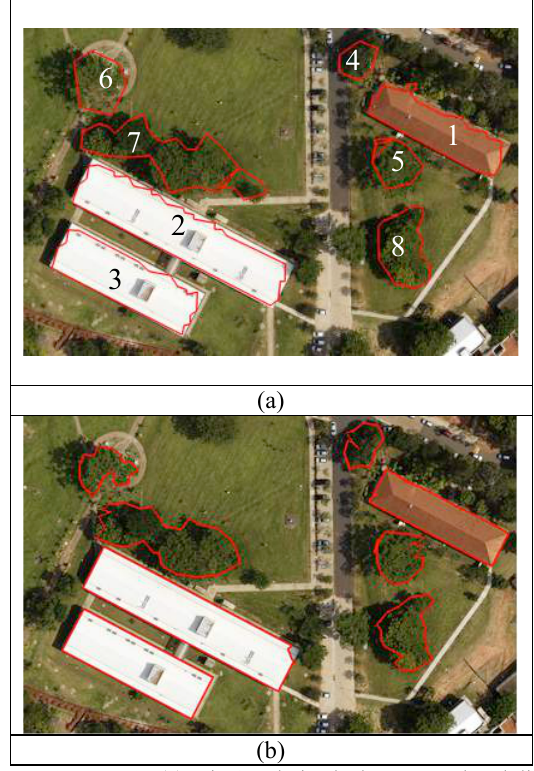
Figure 1. Test 1. (a) LiDAR-derived aboveground polylines projected onto the image; and (b) Polylines extracted from the image The first test aims at verifying the performance of the proposed method in the extraction of building roof boundaries in a relative simple configuration, in which buildings are clearly separated in the image. As can be seen in Figure 1, the test area contains three buildings, all of them with simple rectilinear